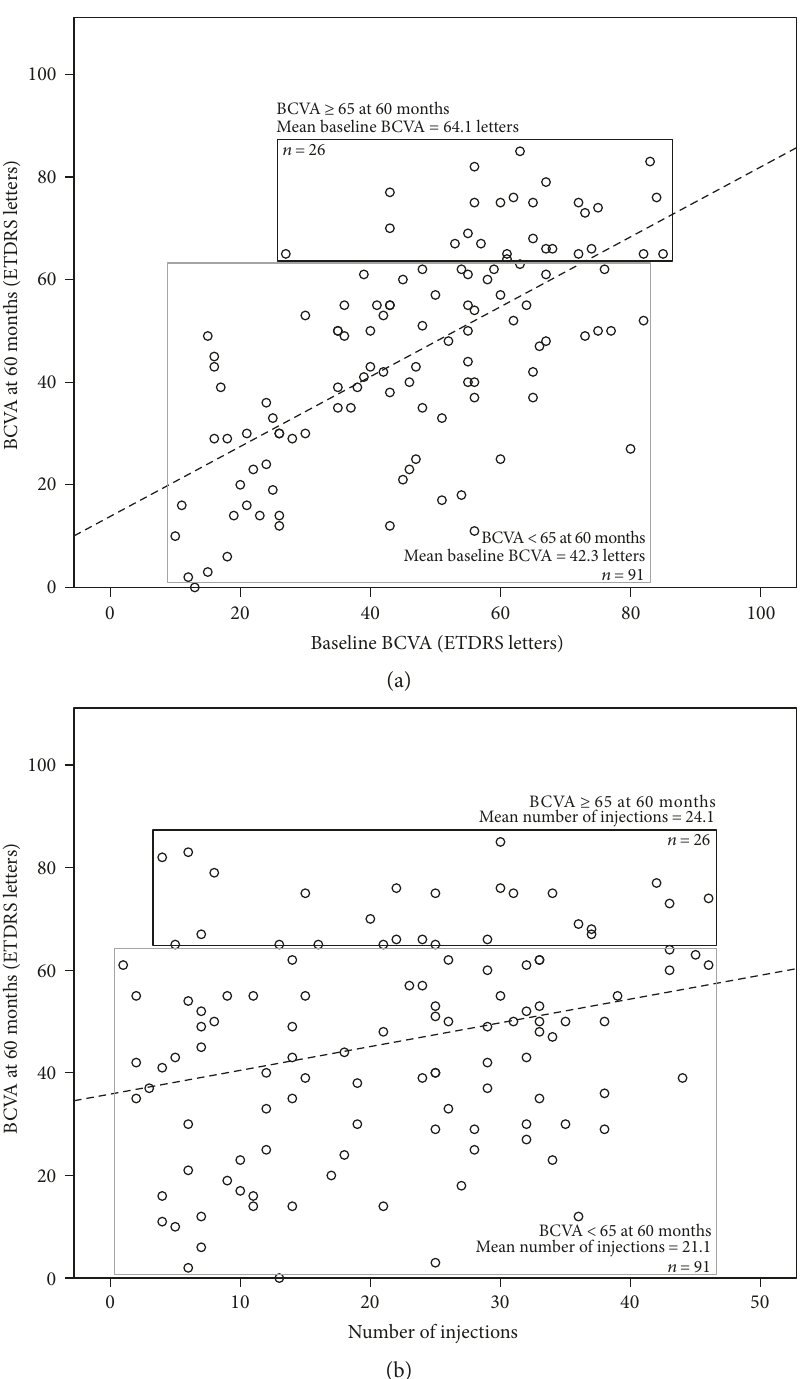
Figure 2: Predictive variables of fi nal best-corrected visual acuity at 60 months. (a) Better BCVA at baseline predicted higher fi nal BCVA score and greater likelihood of achieving 65 ETDRS letters or better, at 60 months. Dashed line = fi tted simple linear regression line. (b) Higher number of injections predicted higher fi nal BCVA score, at 60 months. Dashed lined = fi tted simple linear regression line. BCVA, best-corrected visual acuity; ETDRS, early treatment diabetic retinopathy